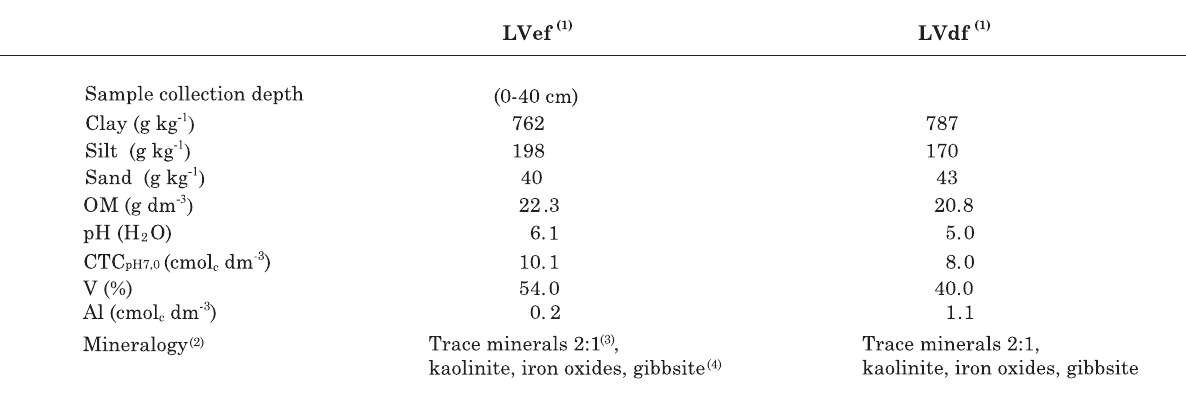
Table 1. Physical and chemical characterization of samples of eutrophic (LVef) and dystrophic (LVdf) Red Oxisols, collected under native